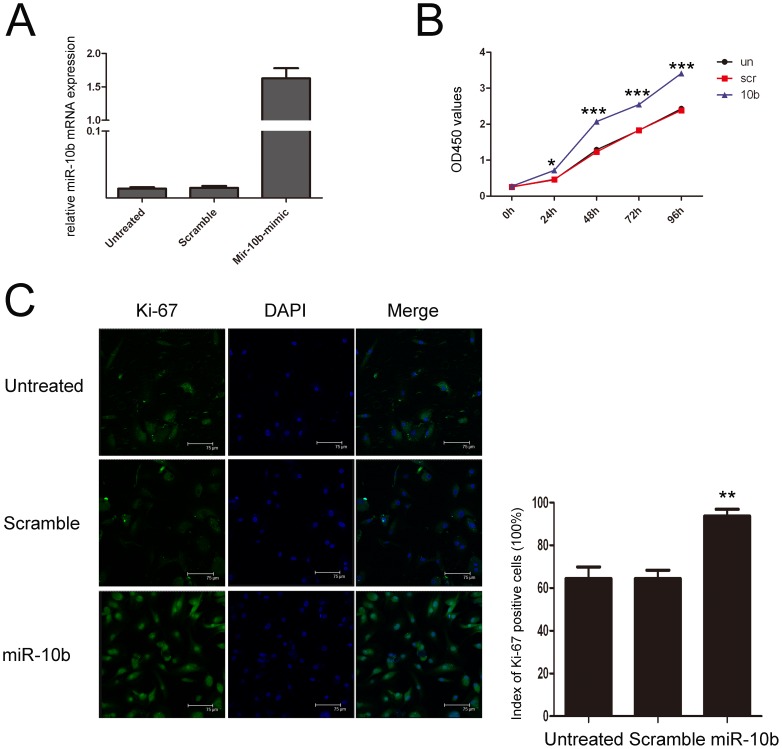
Overexpression of miR-10b promotes NP cells growth.(A) Expression levels of miR-10b were examined by real-time PCR after transfection of 50 nmol/L of miR-10b mimics or sramble or no transfection. (B) Growth of NP cells were shown after transfection with 50 nmol/L of miR-10b mimics or sramble or no transfection. The growth index as assessed at 1, 2, 3, 4, and 5 days. (C) Immunohistochemical staining of NP cells against Ki-67. Nuclei were stained with DAPI, shown in blue. Images were acquired using laser scanning confocal microscopy under a 40× objective. Ki-67-positive percentages in cultured NP cells 48 h after transfection with 50 nmol/L of miR-10b mimics or sramble or no transfection. Values are presented as mean ±SD. As compared with control, **p<0.01, *p<0.05, and **p<0.01.